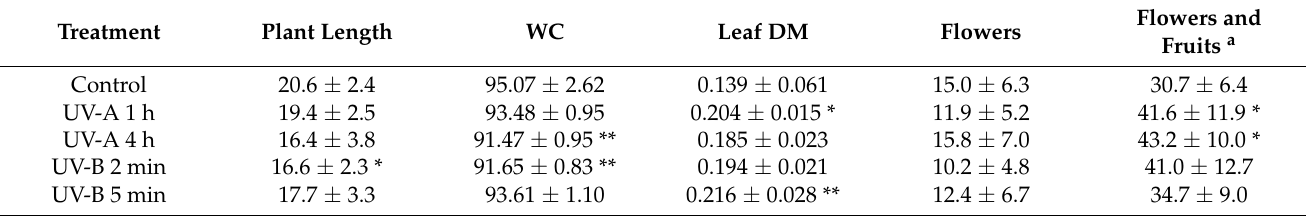
Table 1. Growing and fruit production of S. lycopersicum plants exposed for thirty days to different UV-A/B conditions and control. These parameters were recorded in the last day of the experiment. Plant length (cm), leaf dry matter per unit of fresh matter (mg g(FM) − 1 ), water content (%), number of flowers as well as flowers and fruits values. For the same parameter, * and ** represent statistically significant differences for p ≤ 0.05 and 0.01, respectively. Values are expressed as the mean and standard deviation (n =